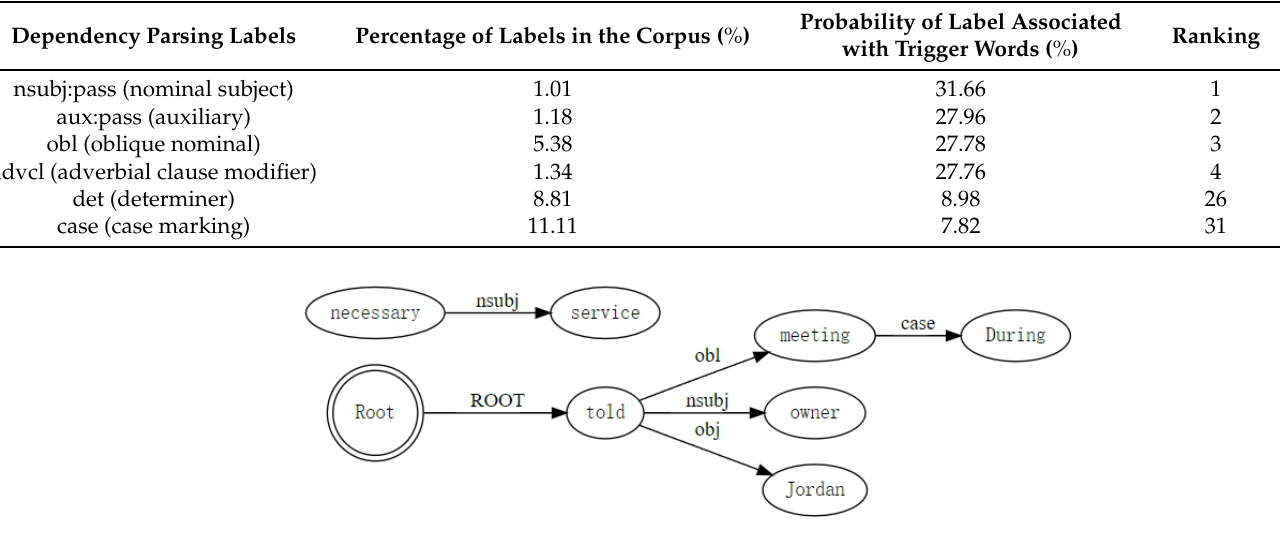
Figure 3. The result of pruning dependency syntax tree